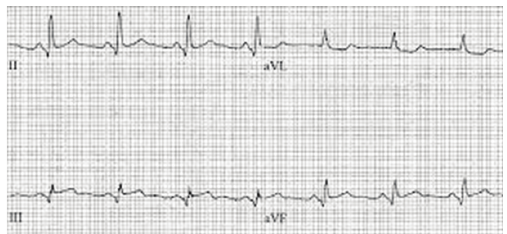
Figure2:STsegmentelevationinleadII,III,andaVFwithelevation of troponins; additional stent placed 72 hours s/p LAD & LCA stent